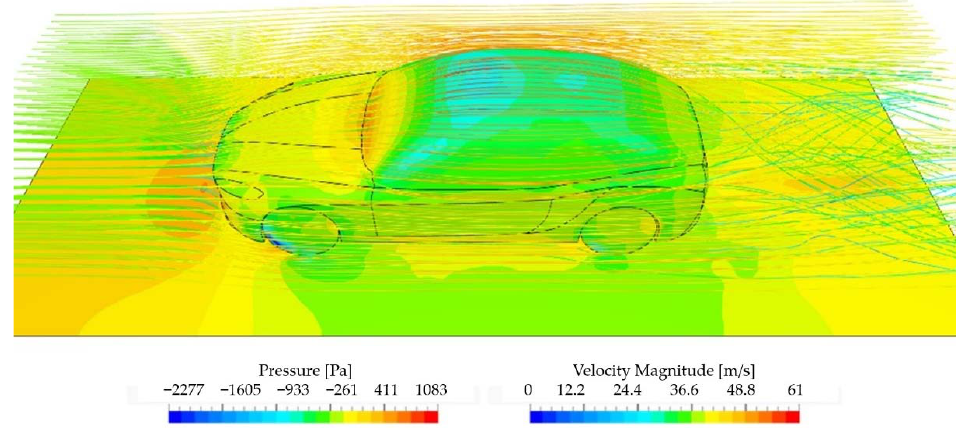
Figure 17. Numerical results of the CFD simulations.